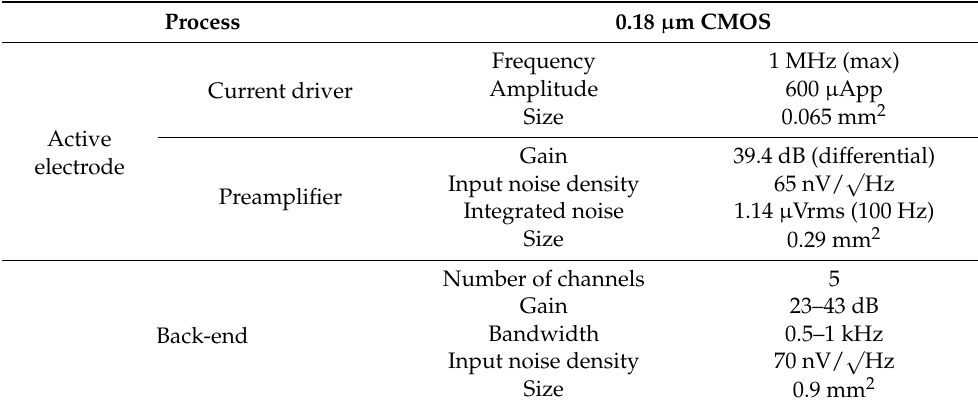
Table 2. Performance Summary.